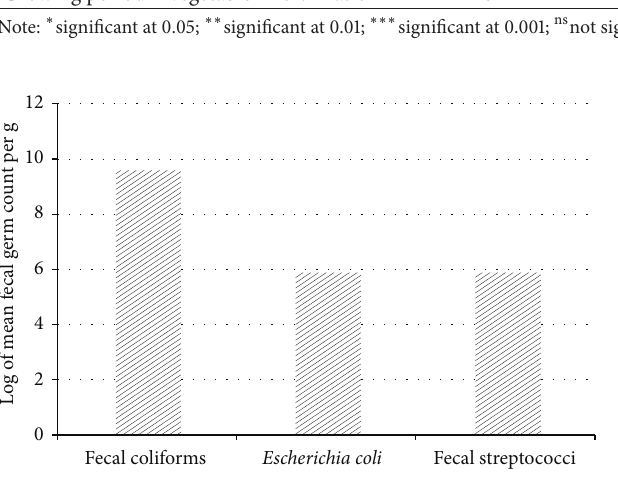
Figure 4: Populations of the three fecal bacteria per fertilization treatment: T0, unfertilized control; T1, mineral fertilization (urea + NPK); T2, mineral fertilization + 10t ⋅ ha −1 of poultry manure; and T3, 40t ⋅ ha −1 of poultry manure (coastal area of Benin, 2009- 2010, 288 plots). The fertilization, with or without poultry manure, had no significant impact on the high initial contamination of the